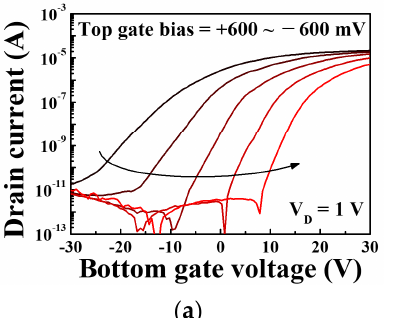
Figure 7. ( a ) Transfer characteristic curves of the SiNW channel DG FET during the bottom gate operation with a constant top gate bias varying from +600 to − 600 mV (in steps of 300 mV). ( b ) Variation in the top gate bias with Δ V ref .